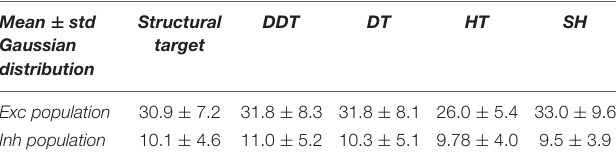
TABLE 2 | Mean and standard deviation of the fitting gaussian curve.